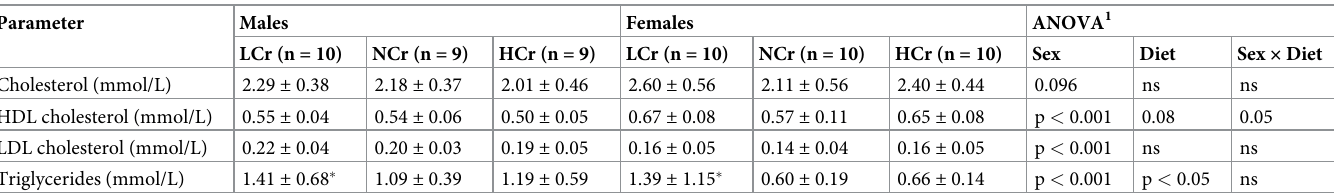
Table 3. Serum lipid profile of